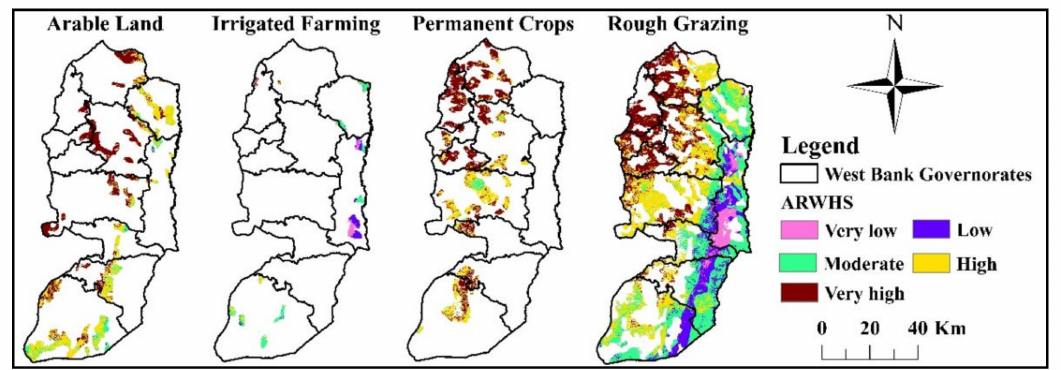
Figure 9. ARWHS-agricultural lands intersection map for the West Bank case